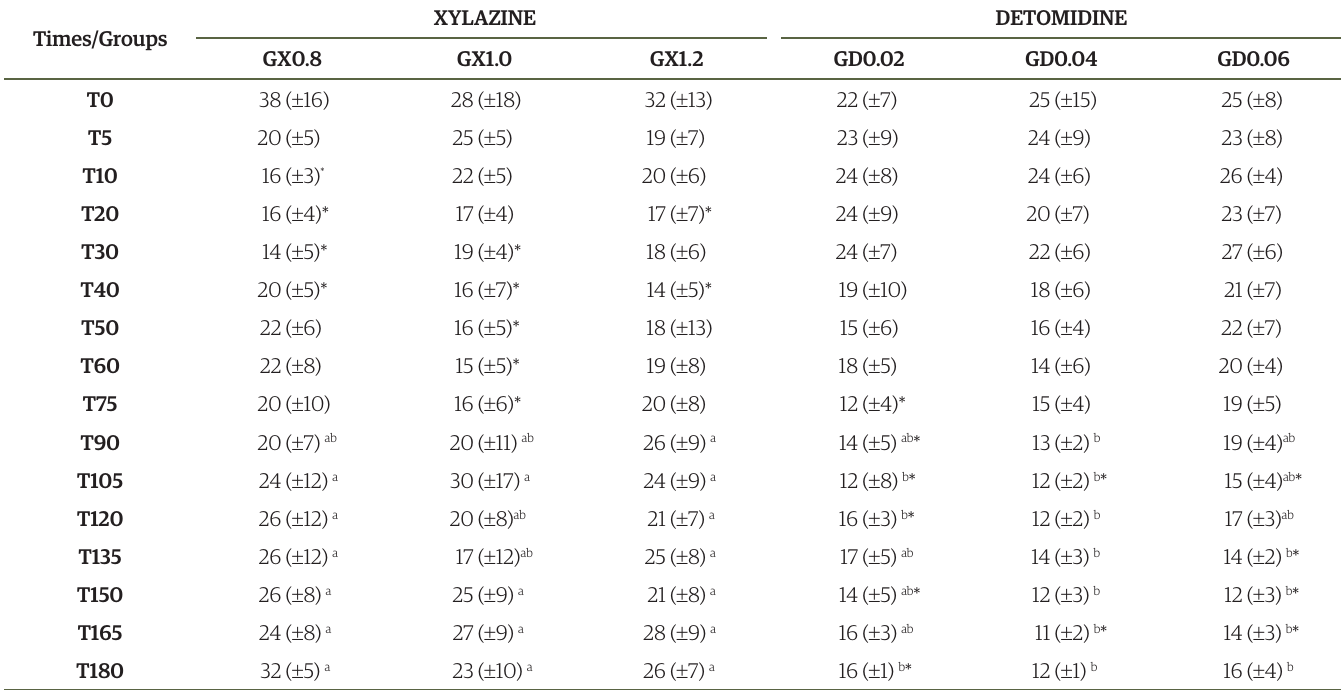
Table 6. Median ( ± Semi-interquartile range) respiratory rate (mpm) in donkeys from northeast Brazil sedated with detomidine or xylazine, given intravenously in different